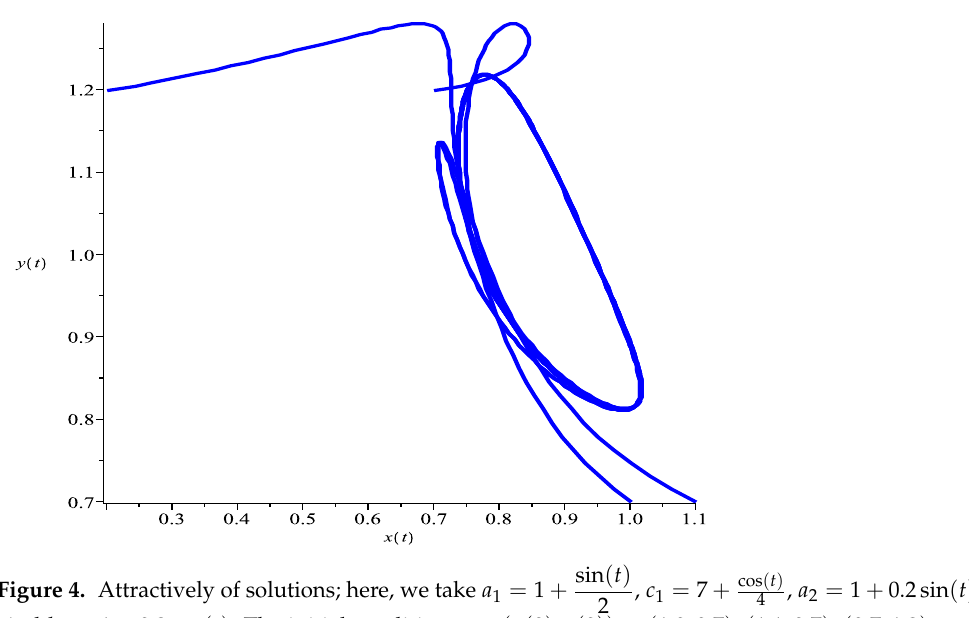
Figure 4. Attractively of solutions; here, we take a 1 = 1 + ajnd b 2 = 1 − 0.2cos ( t ) . The initial conditions are ( x ( 0 ) , y ( 0 )) = ( 1.0,0.7 ) , ( 1.1,0.7 ) , ( 0.7,1.2 ) , and ( 0.2,1.2 )